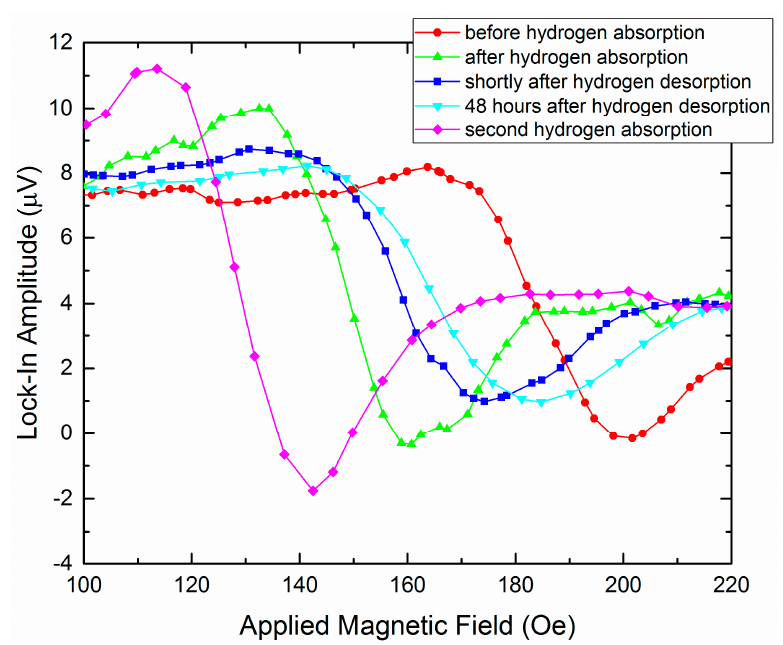
Figure 14. In situ FMR response of a 8.36 nm Co/13.50 nm Pd bilayer at various stages during the hydrogen absorption and desorption cycling PNR experiment.